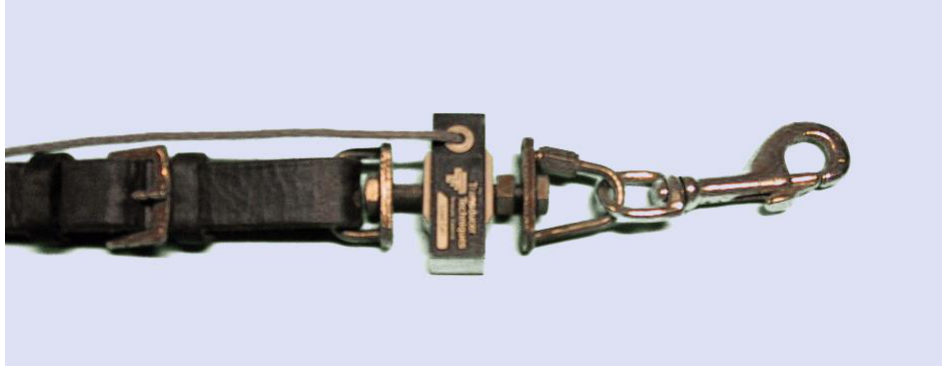
Figure 5. Strain gauge attached securely to the rein (left) with a metal clip for attachment to the bit. Note that none of the components are elastic. (image from [5]).